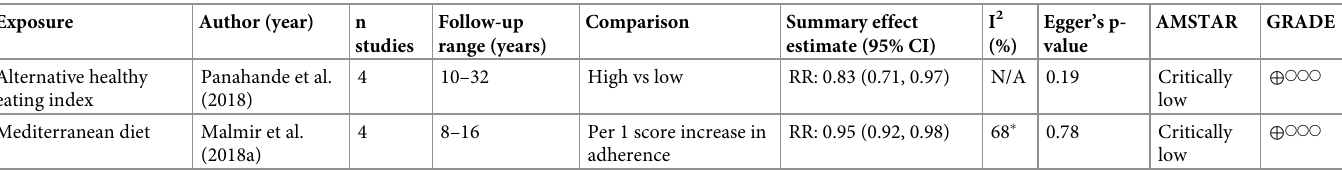
Table 1. Summary characteristics and findings of meta-analyses of cohort studies assessing associations between dietary patterns and hip fracture risk.